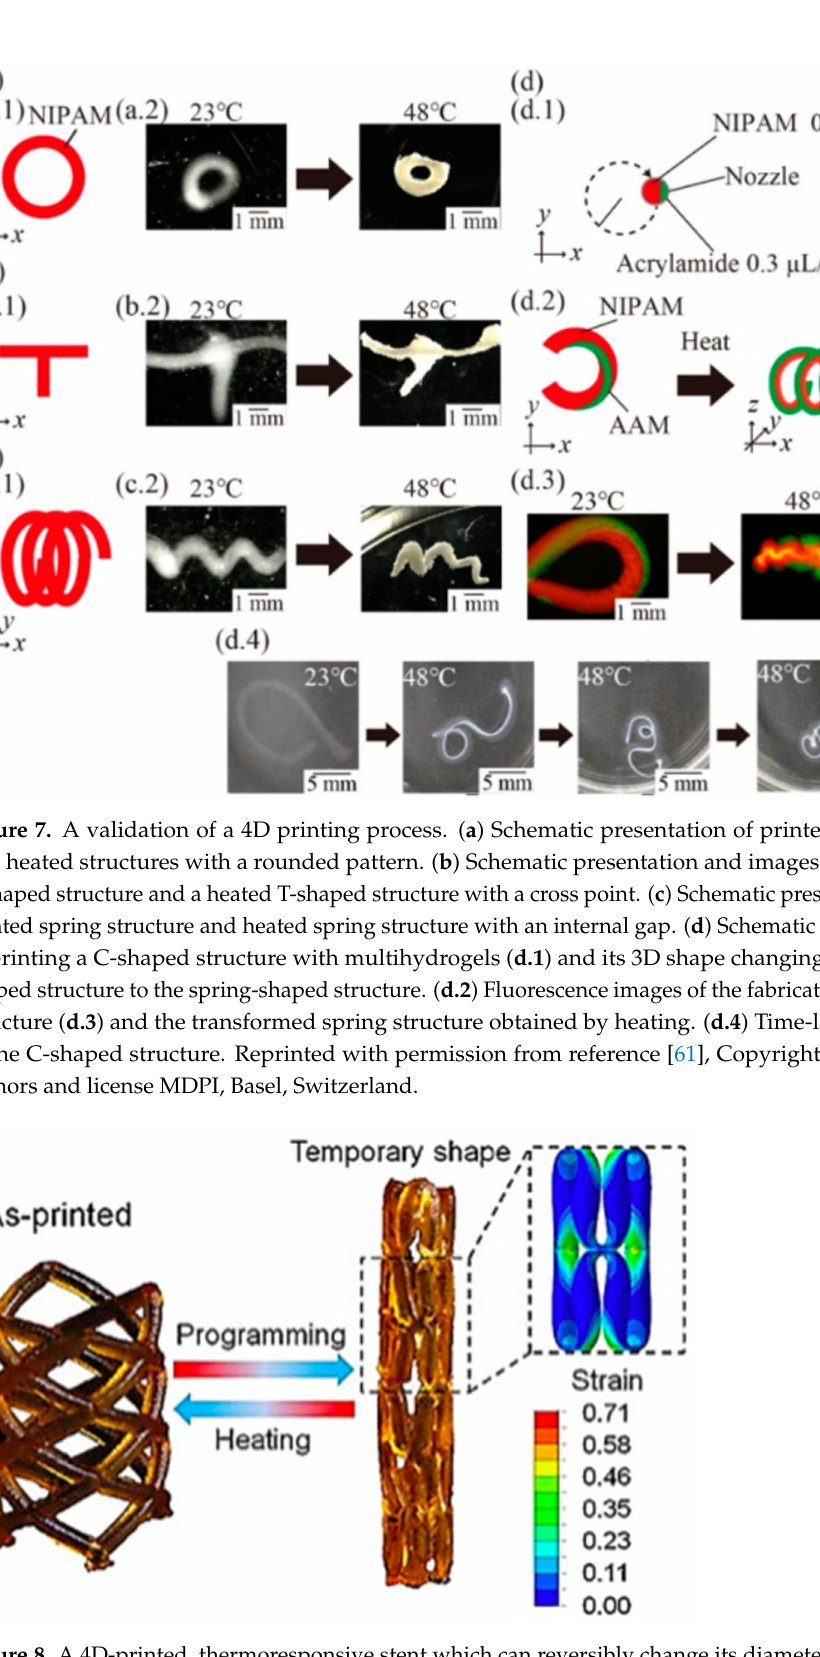
Figure 8. A 4D-printed, thermoresponsive stent which can reversibly change its diameter and height. Reprinted with permission from reference [73], Copyright 2016,